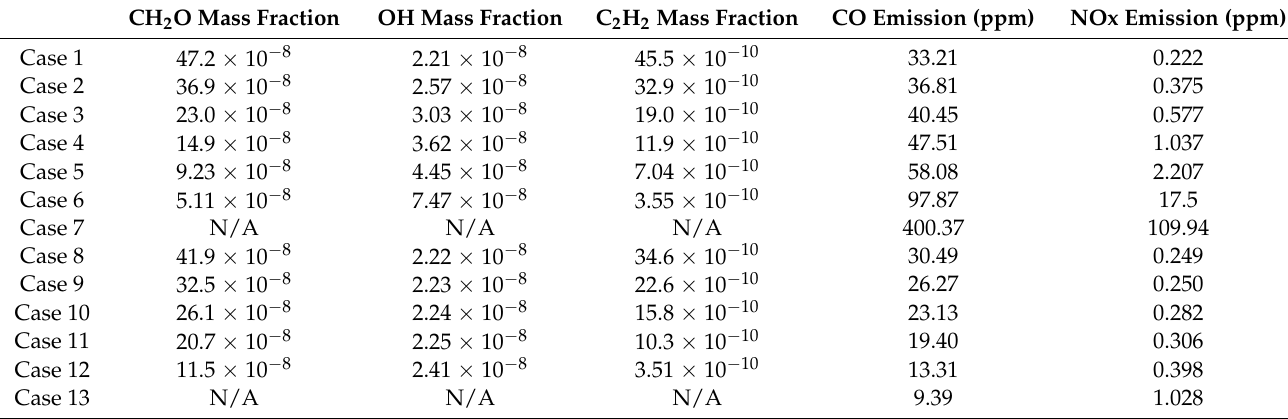
Table 5. Emissions level of combustion chamber’s